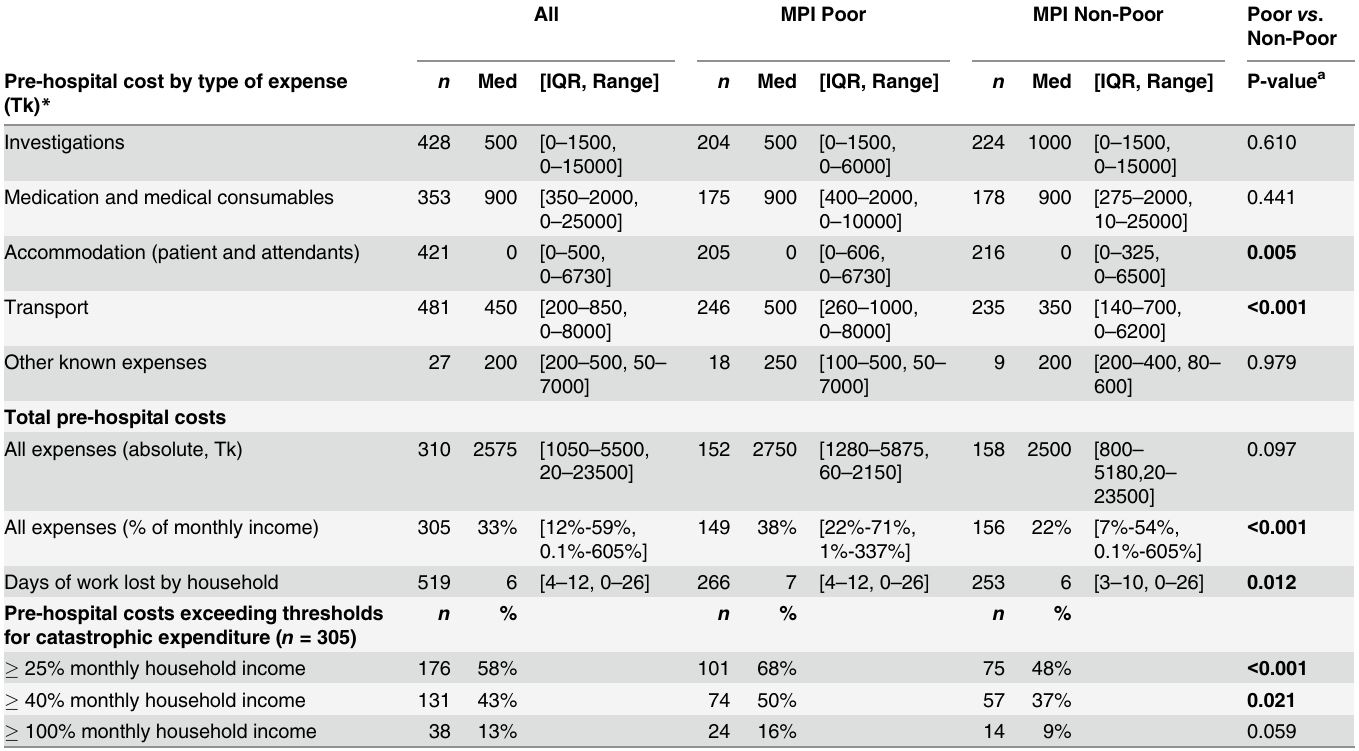
Table 7. Estimated pre-hospital expenditure on medical care, days lost from work by household members, and proportion of MPI groups experiencing catastrophic expenditure. All MPI